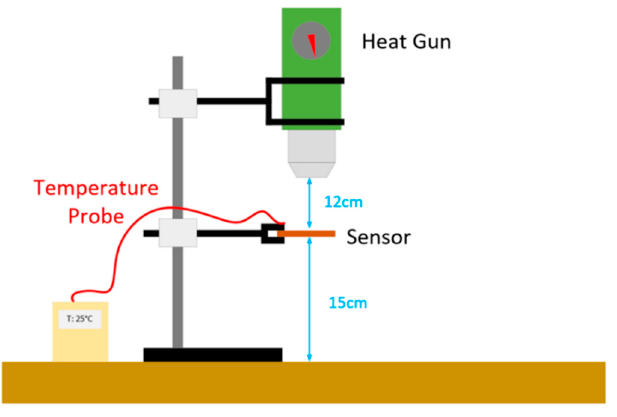
Figure 4. Wired sensor testing configuration.